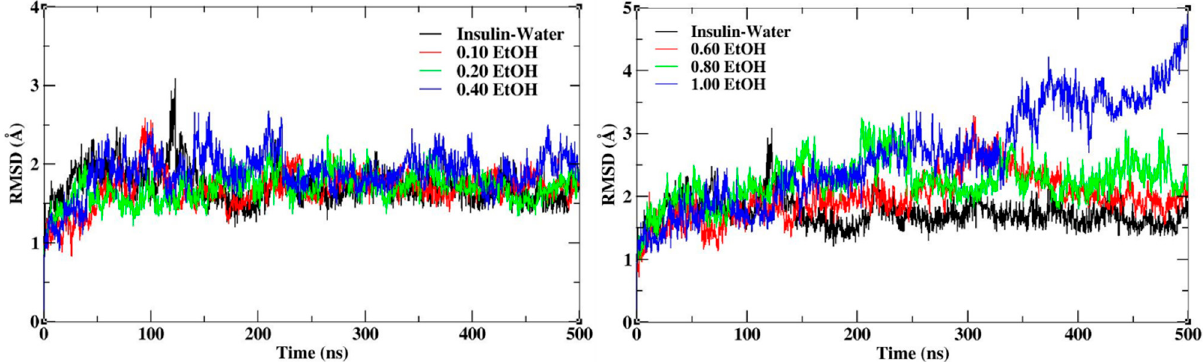
Figure 2. RMSD plots of insulin backbone with different mole fractions of